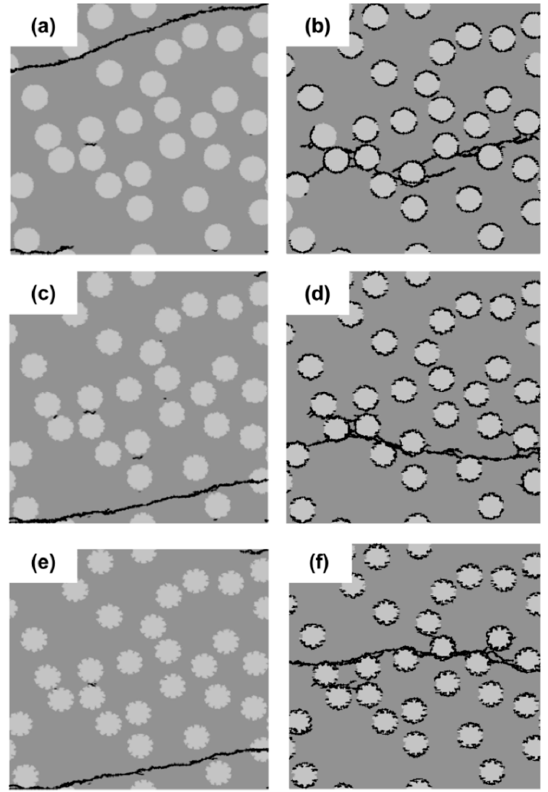
Figure 11. Micro-crack patterns of specimens with a strong interface (left) and a weak interface (right) for three different surface roughnesses of filler particles (Roughness 1 ( a , b ); Roughness 2 ( c , d ) and Roughness 3 ( e , f